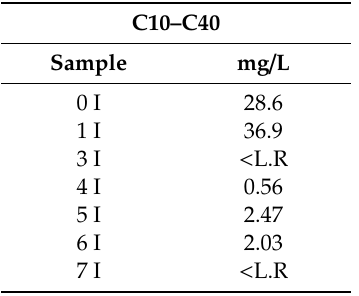
Table 3. Hydrocarbon content (C10–C40) in the water